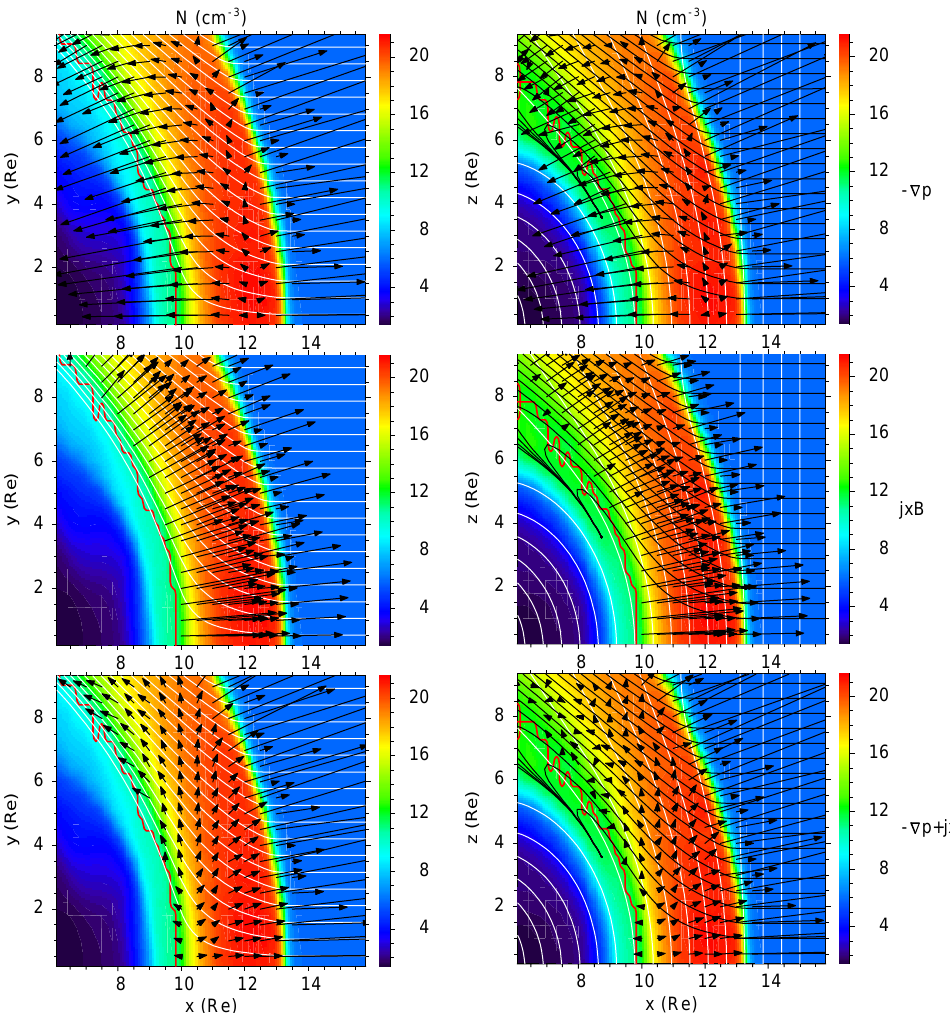
Fig. 7. The pressure gradient force, the magnetic force, and their combined force in the equatorial or z =0 plane (the left panels) and the noon-midnight or y =0 plane (the right panels). The open-closed magnetic field boundary is shown as a red zigzag curve, and the plasma density is shown color coded as the background in each panel. The streamlines are shown with white and black smooth curves in the left and the right panels, respectively. Field lines are shown with white smooth curves in the right panels. The arrows in each panel show the force vectors. The arrows are properly scaled within each panel and among different panels. Note that the streamlines are only drawn on a plane, so they may not represent the real three-dimensional